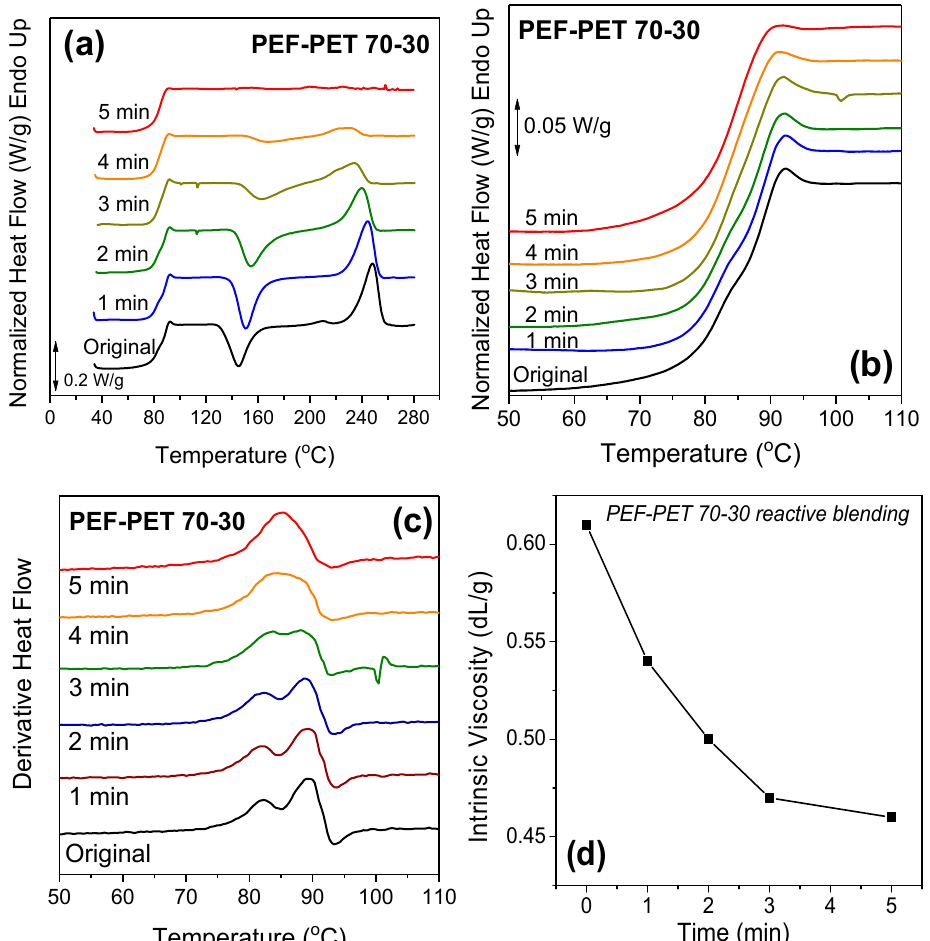
Figure 8. ( a ) Effect of time of reactive blending at 280 °C on the DSC thermograms of the PEF–PET 70–30 blends, ( b ) zoomed-in area of the blends prepared by reactive blending at different times, ( c ) derivative of heat flow of the PEF–PET 70–30 samples prepared by reactive blending, and ( d ) the variation of the intrinsic viscosity with reactive blending time.